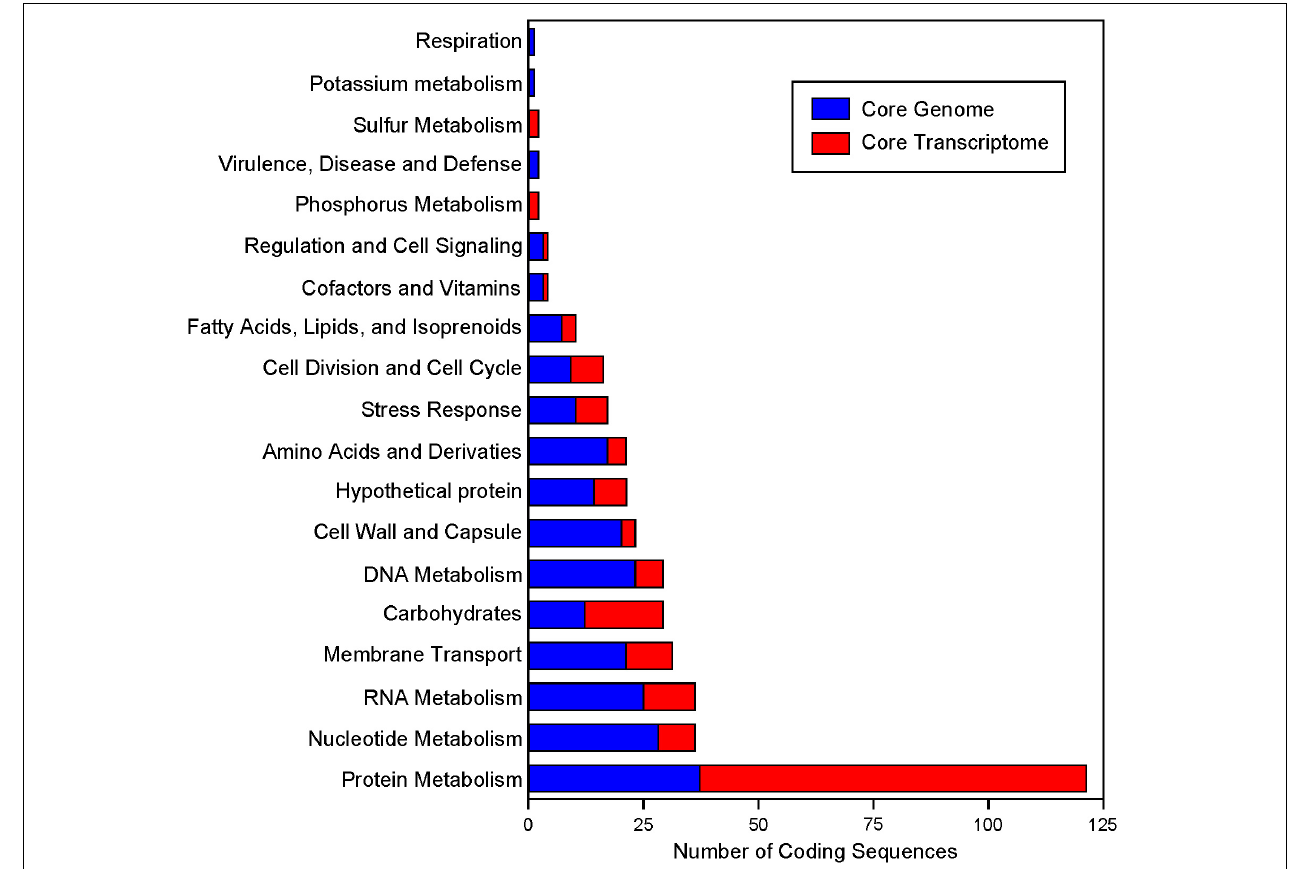
FIGURE 7 | Functional annotation of the core genome and core transcriptome. RAST annotations were obtained for the core genome. The highest level functional “Category” is plotted. Genes that are part of the core genome and core transcriptome are colored in